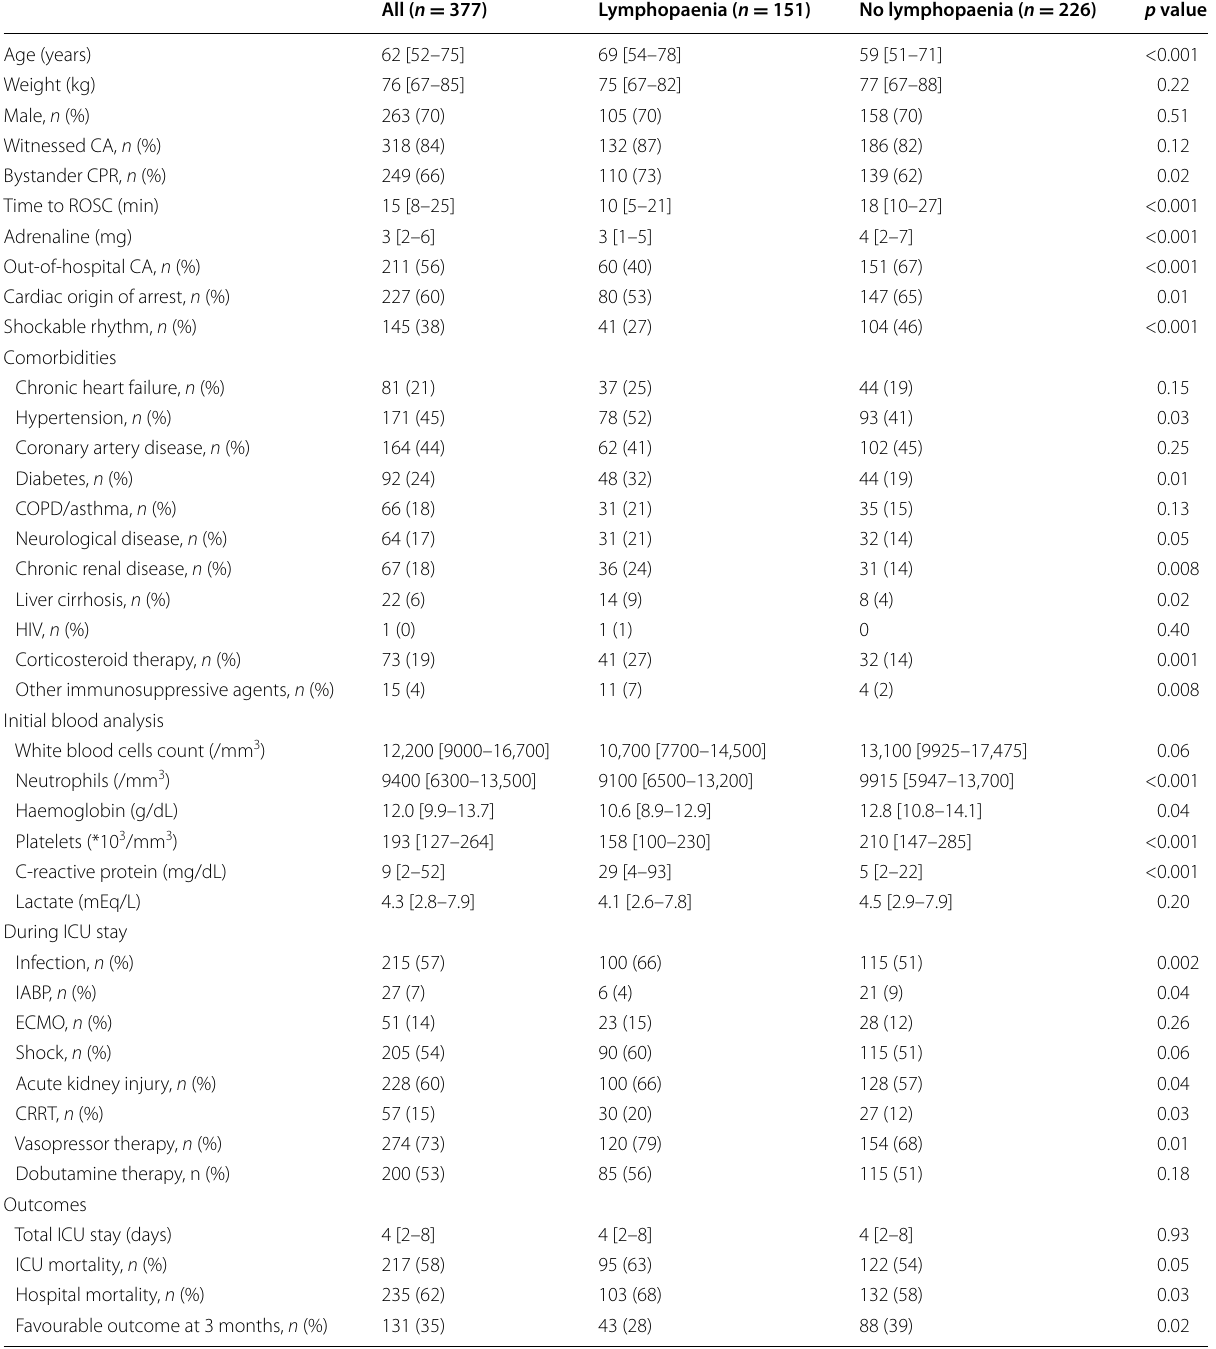
Table 1 Characteristics of study population according to the presence of lymphopaenia on